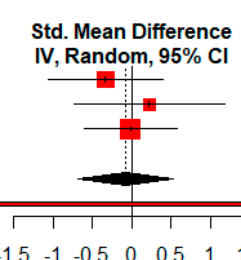
Figure 13. Effectiveness of cognitive rehabilitation in quality of life. Figure 13 . Effectiveness of cognitive rehabilitation in quality of life.